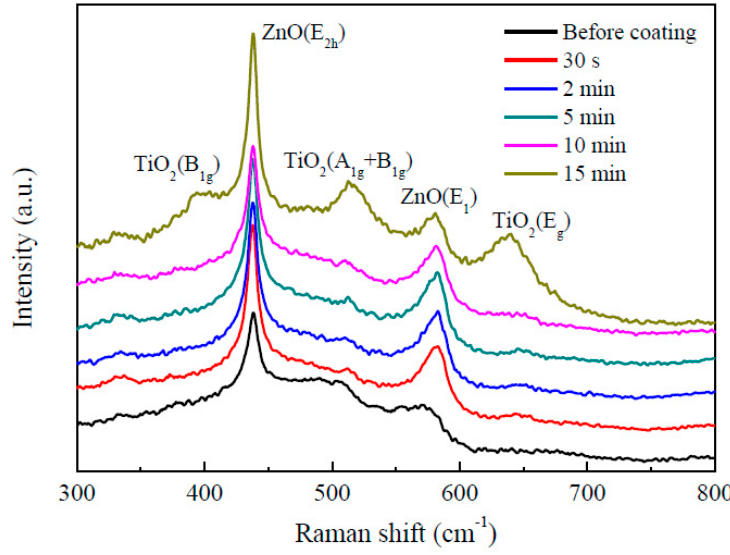
Figure 5. Raman spectra of the as-deposited ZnO nanorods and ZnO nanorods coated with TiO 2 by mist mist CVD.